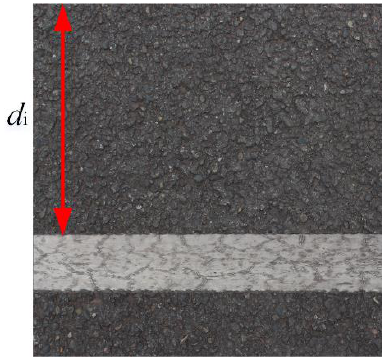
Figure 4. Raw label image. The d i is the distance from bottom edge of lane to asphalt.